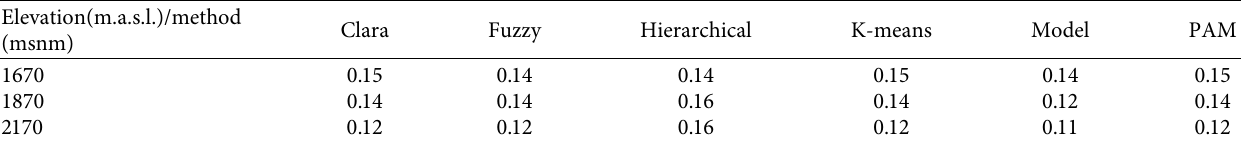
Table 6: Measure of adjustment d 1/2 for residuals orthogonal to elevation and method.